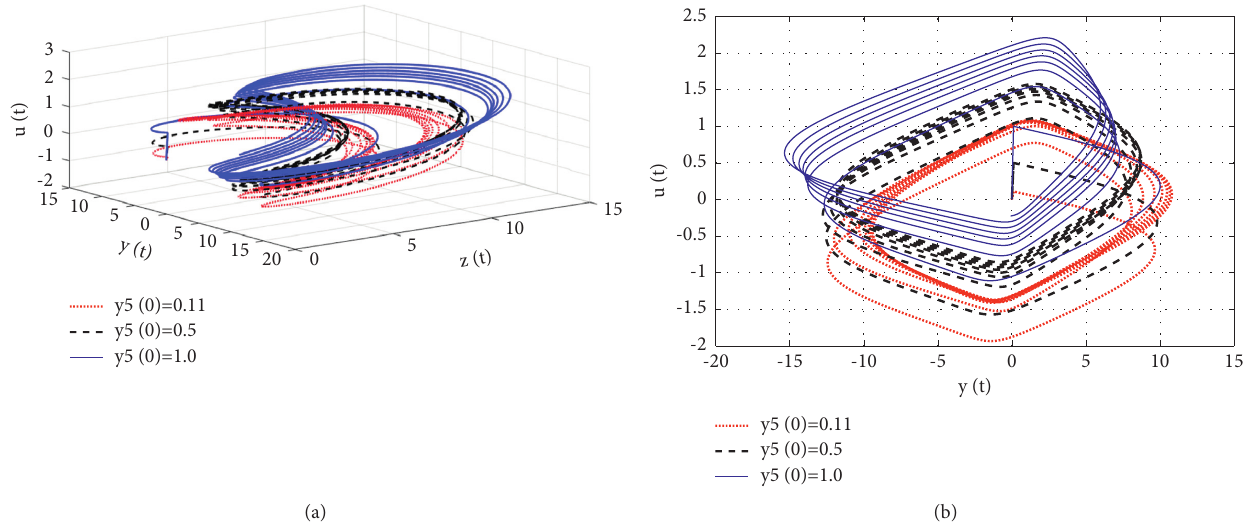
Figure 10: Some of the Phase portraits of the system (25) due to small changes in the initial condition. (a) z-y-u space. (b) y-u